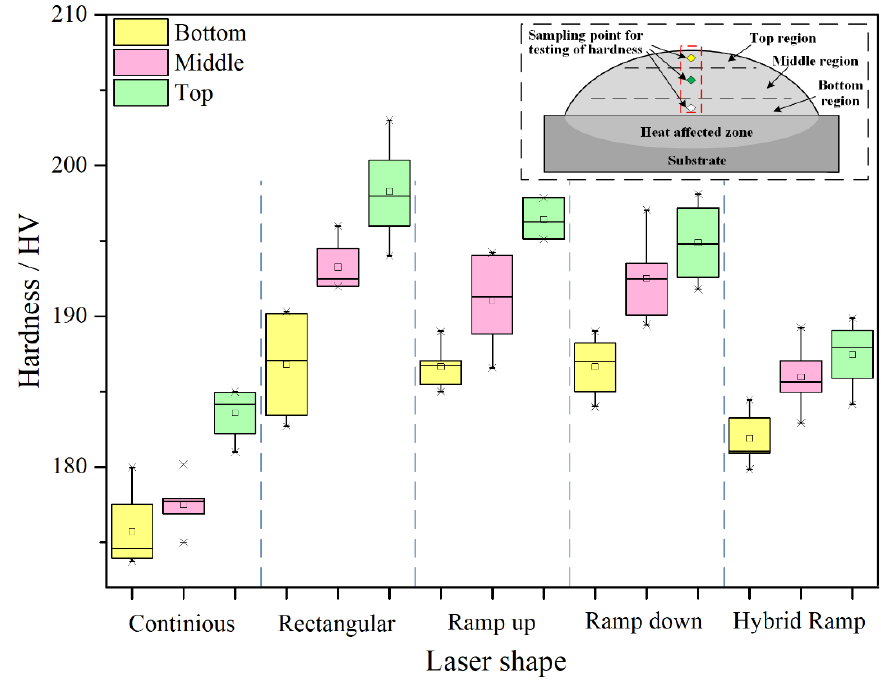
Figure 7. Microhardness at different regions of deposition produced by different laser